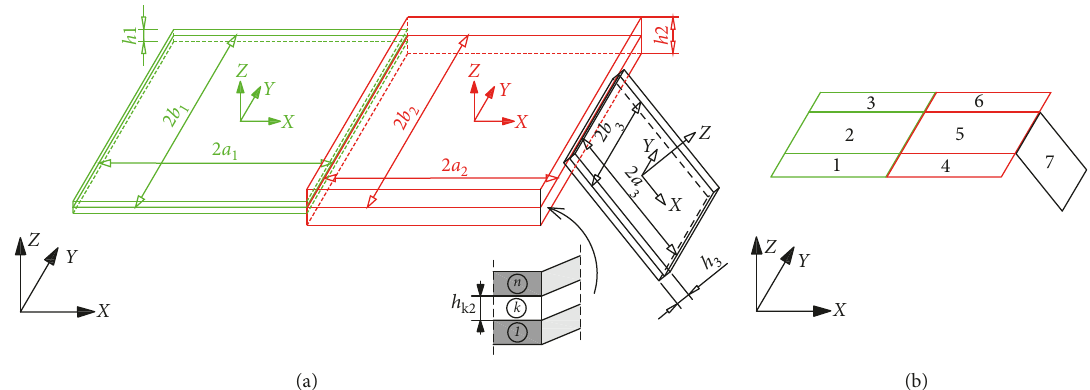
Figure 1: Assembly of (a) three arbitrarily oriented multilayer plates and (b) seven dynamic stiffness elements.